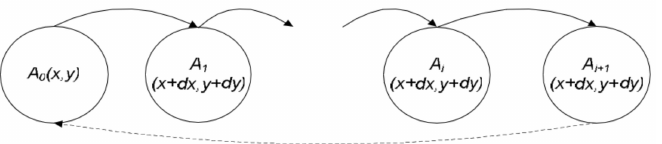
Figure 5. Structural image of the vector representation of the object on the thermogram of the steel ladle. Performing vectorization makes it possible to link disparate parts of one element, as well as reduce the amount of data for further analysis. The result of vectorization of the thermogram of the steel ladle is shown in Figure